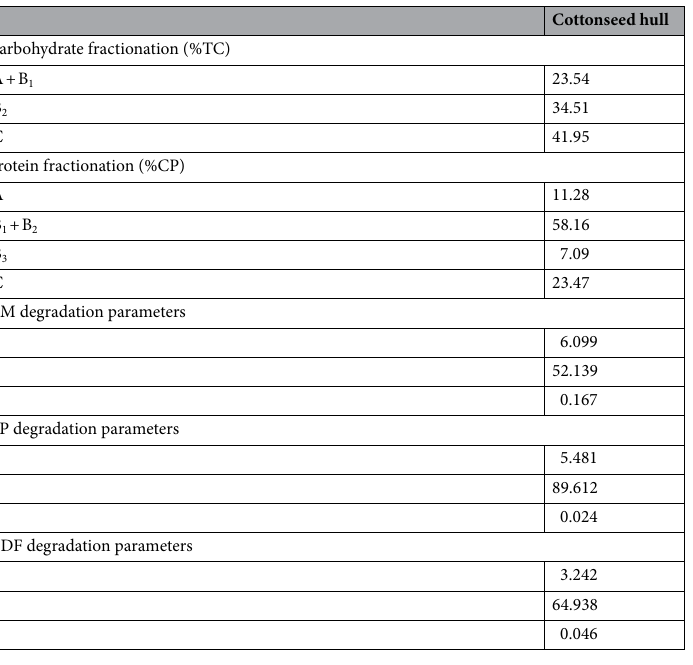
Table 5. Carbohydrate and protein fractionation, and degradation parameters of DM, CP, NDF from cottonseed hull. A + B 1 = Non-fibrous carbohydrate (%TC); B 2 = potentially digestible neutral detergent fibre (%TC); C = unavailable; A = non-protein nitrogen; B 1 +B 2 = true protein degradable in the rumen; B 2 = true protein with intermediate degradation rate in the rumen; B 3 = true protein with slow degradation rate in the rumen, C = unavailable or cell-wall bound true protein; (a) water-soluble fraction; (b) water-insoluble fraction potentially degradable in the rumen as a function of time; (c) rate of degradation per fermentative action of b. TC total carbohydrate.